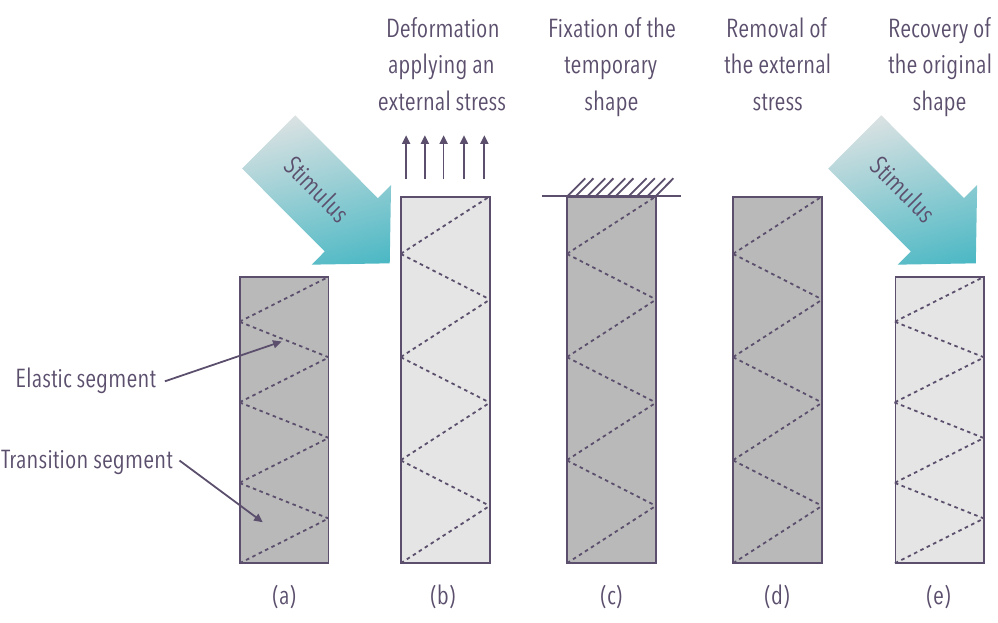
Figure 5. The mechanism for the shape-memory e ff ect in shape-memory polymers is the dual-segment / domain system. ( a ) Native configuration; ( b ) external stimulus, inducing modulus drop, enables deformation after application of an external force; ( c ) fixation of the temporary configuration; ( d ) removal of the external force; ( e ) recovery of the native